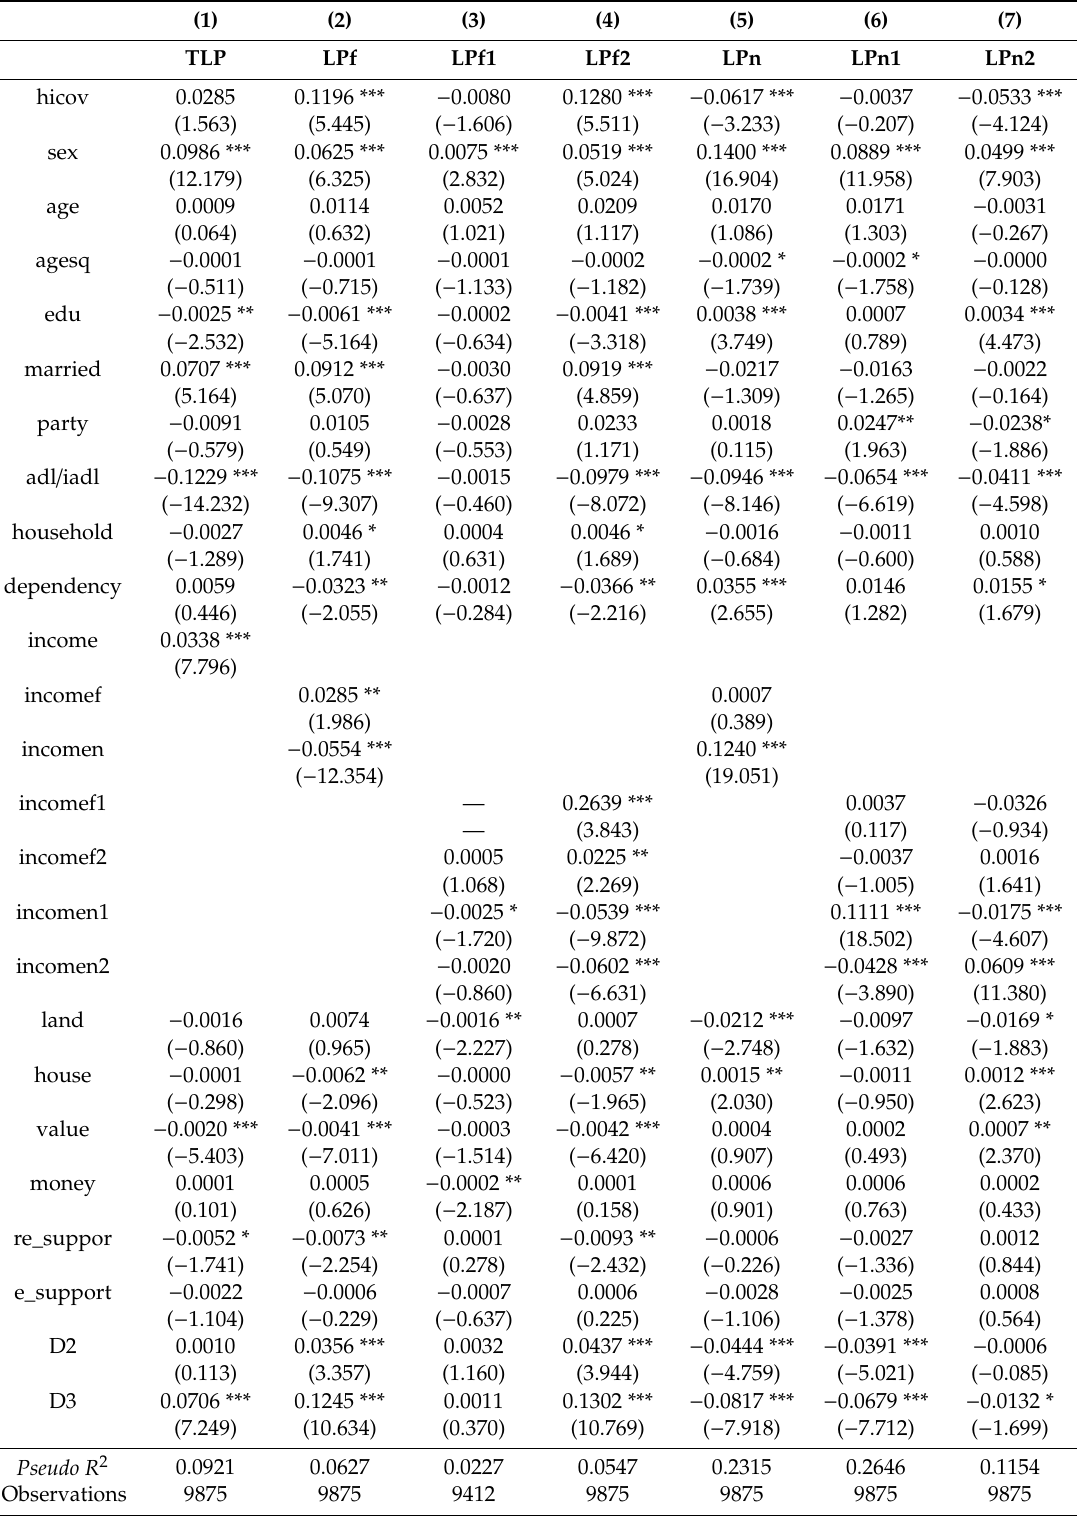
Table 6. Model estimation of labor participation in health